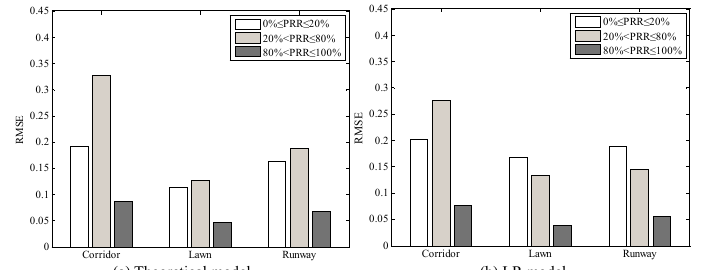
Figure 25. RMSEs of SNR based LQEs in different regions.